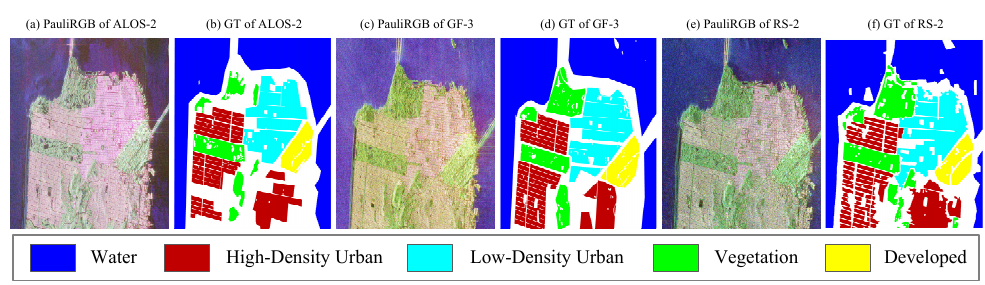
Figure 6. Pauli RGB and ground truth maps of the San Francisco datasets and the color code. ( a , b ) ALOS-2 San Francisco dataset. ( c , d ) GF-3 San Francisco dataset. ( e , f ) RS-2 San Francisco